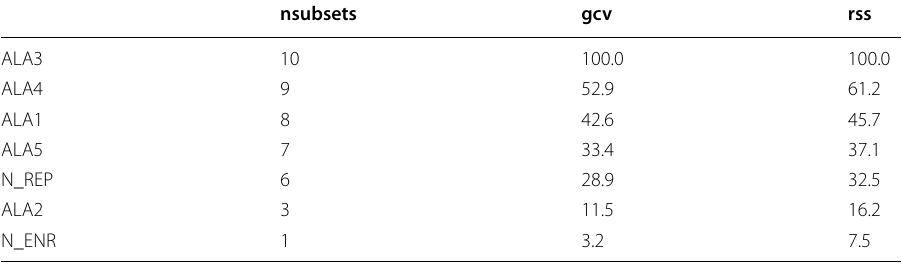
Table 17 Variable relative importance on Markets and behavior MARS